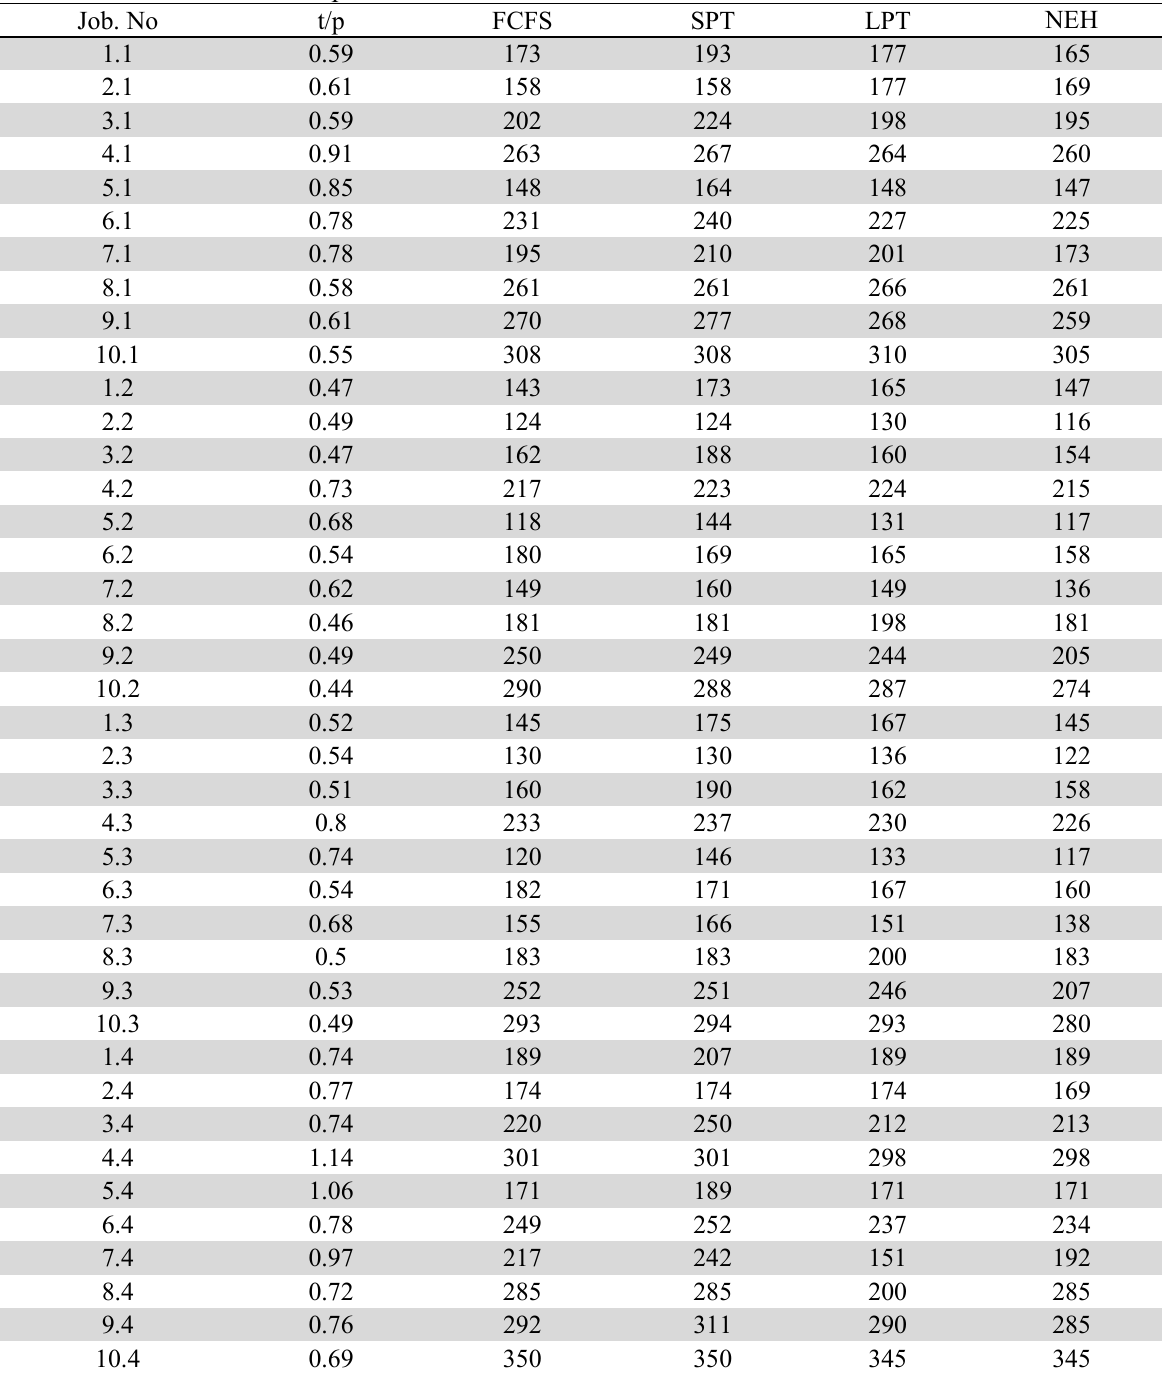
Table 3 Performance assessment for t/p>0.25 Job.